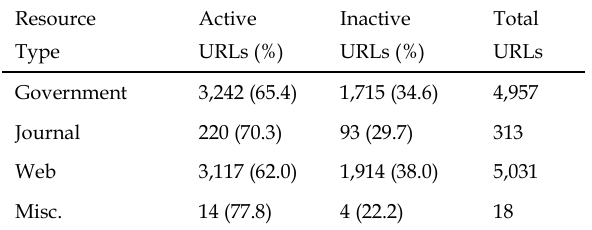
Table 3: Number and percentage of active and inactive URLs by resource type Resource